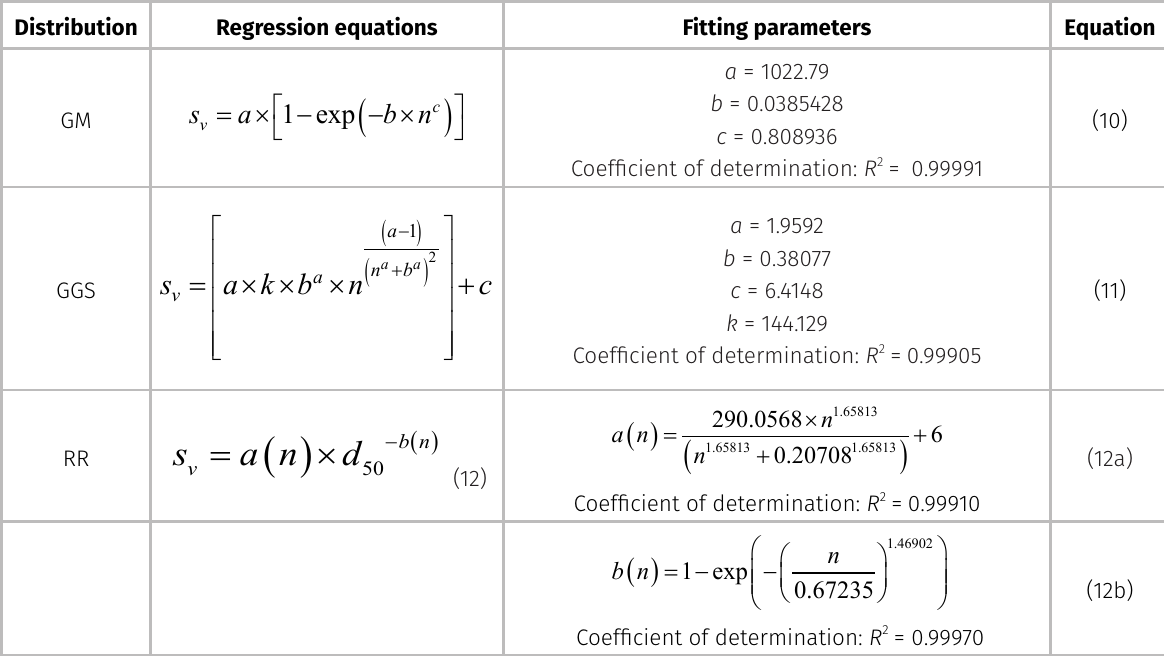
Coefficient of determination: R 2 =